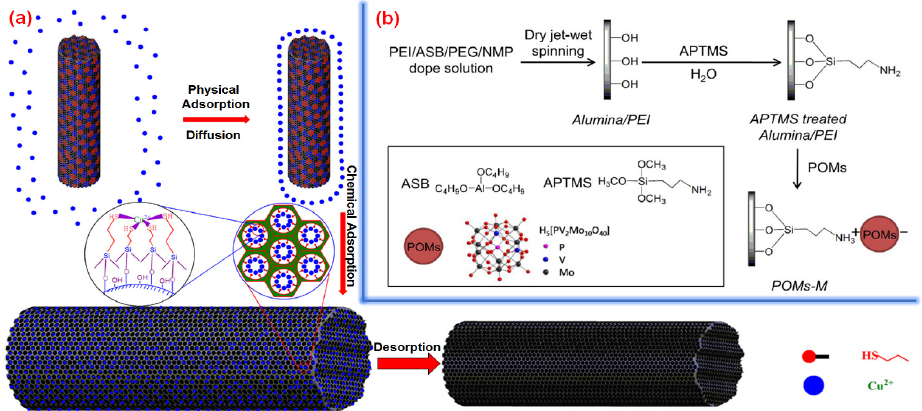
Figure 22. ( a ) Adsorption of Cu(II) via the PVA-SiO 2 nanofiber [202], and ( b ) production of POM- based membrane [210]. Reproduced with permission from [210], copyright of Elsevier.